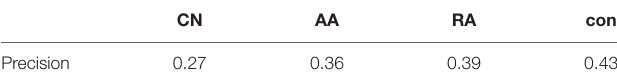
TABLE 8 | When m = 100 is the precision value of each metric.